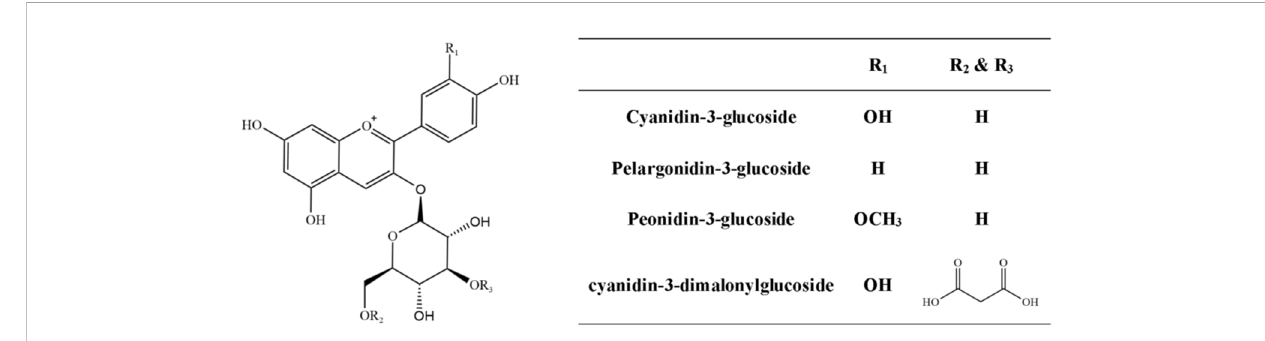
FIGURE 1 Examples of major anthocyanin species in Andean maize.